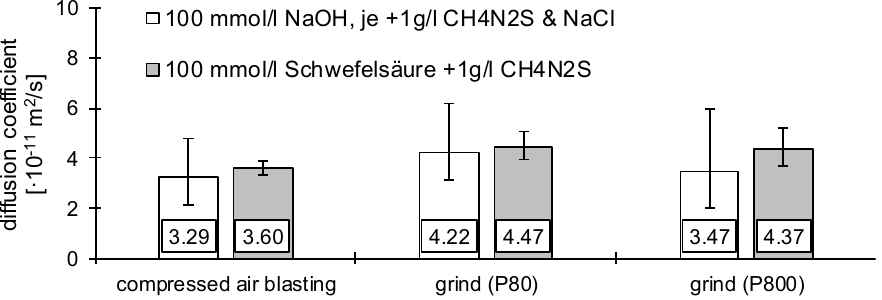
Figure 13. Impact of the surface quality of the samples on the permeation measurement (22MnB5-press-hardened condition).